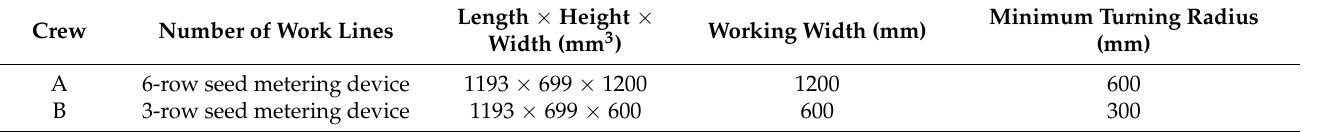
Figure 8. Screenshot of the actual field selected in Google Earth software. ( a ) Field 1 is small, multilateral, and irregular with an area of 67.94 m 2 ; ( b ) field 2 is small and irregular, with an area of 87.23 m 2 ; ( c ) field 3 is large-scale, multilateral and irregular with an area of 1572.97 m 2 ; ( d ) field 4 is large and irregular with an area of 615.35 m 2 .